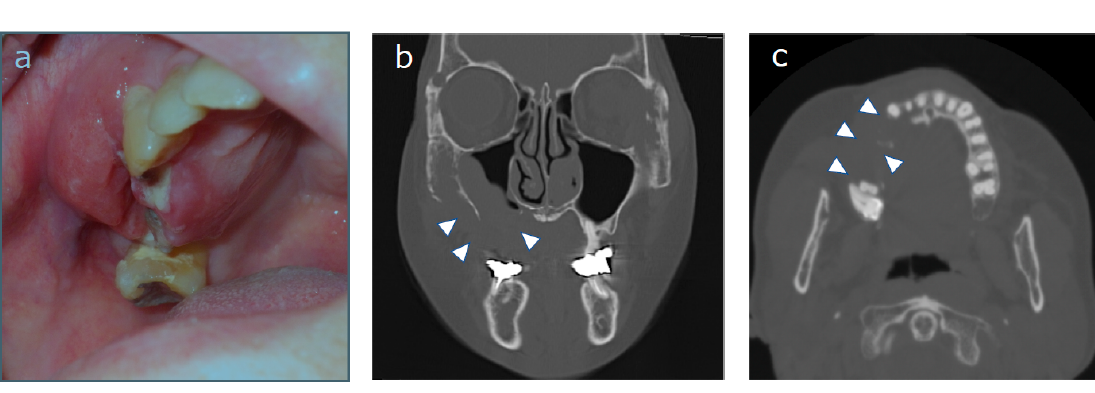
Figure 1. ( a ) An intraoral view at the first examination. A localized, well-defined swelling of size 4 cm × 5 cm in its greatest dimensions was obliterating the buccal and palatal vestibules in the region of the unhealed extraction sockets of 14, 15 and 16. Coronal ( b ) and axial ( c ) computed tomography imaging showed the osteolytic focus in the maxilla (white arrowhead).